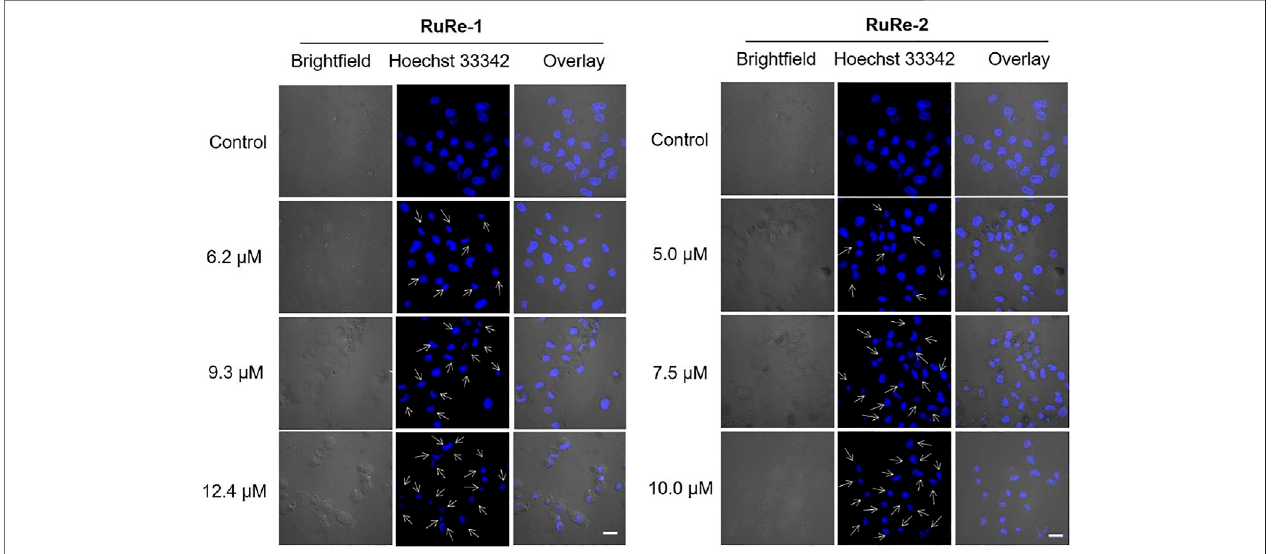
FIGURE 2 | RuRe-1 and RuRe-2 induced HeLa cells apoptosis measured by confocal microscopy with Hoechst 33342 staining ( λ ex = 405 nm, λ em = 460 ± 20 nm). The incubation time of the compounds was 24 h. Arrows indicate apoptotic morphological nuclei. Scale bar: 20 μ m.